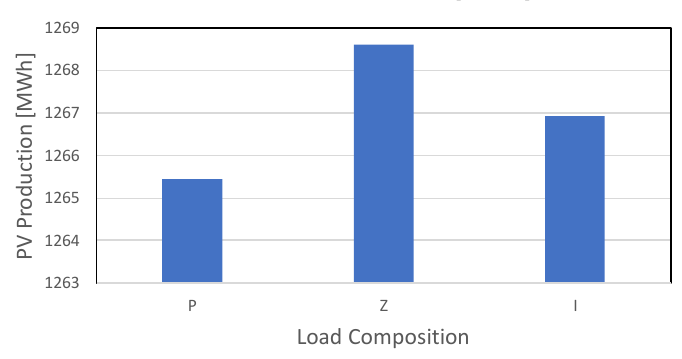
Figure 15. Effect of load composition on energy produced in June.